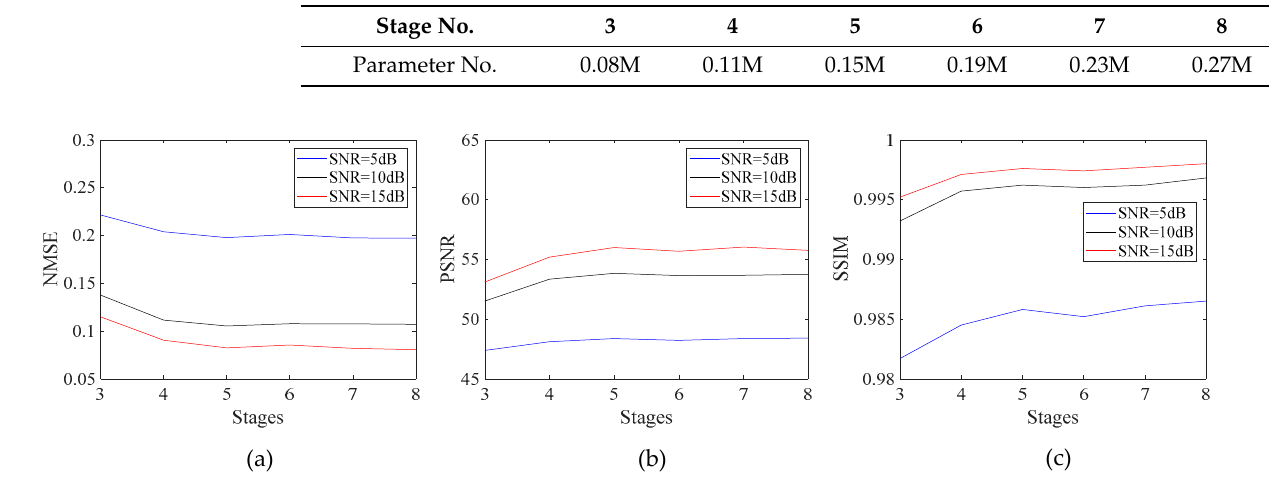
Table 12. Parameters of different stages.